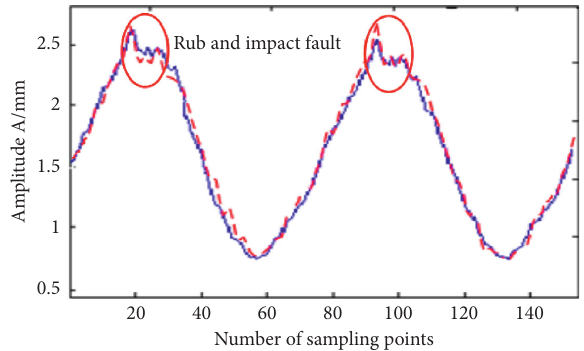
Figure 17: Comparison results of two methods of gear signal. The red line is the result of traditional TDA, and the blue line is the result of multiband filter.